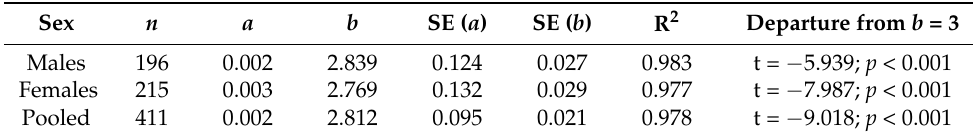
Table 1. Parameters of CL–WW relationship ( W = a CL b ) for males, females, and pooled sexes of Palinurus elephas caught during the period 2000–01. a : intercept; b : allometric coefficient; SE: standard